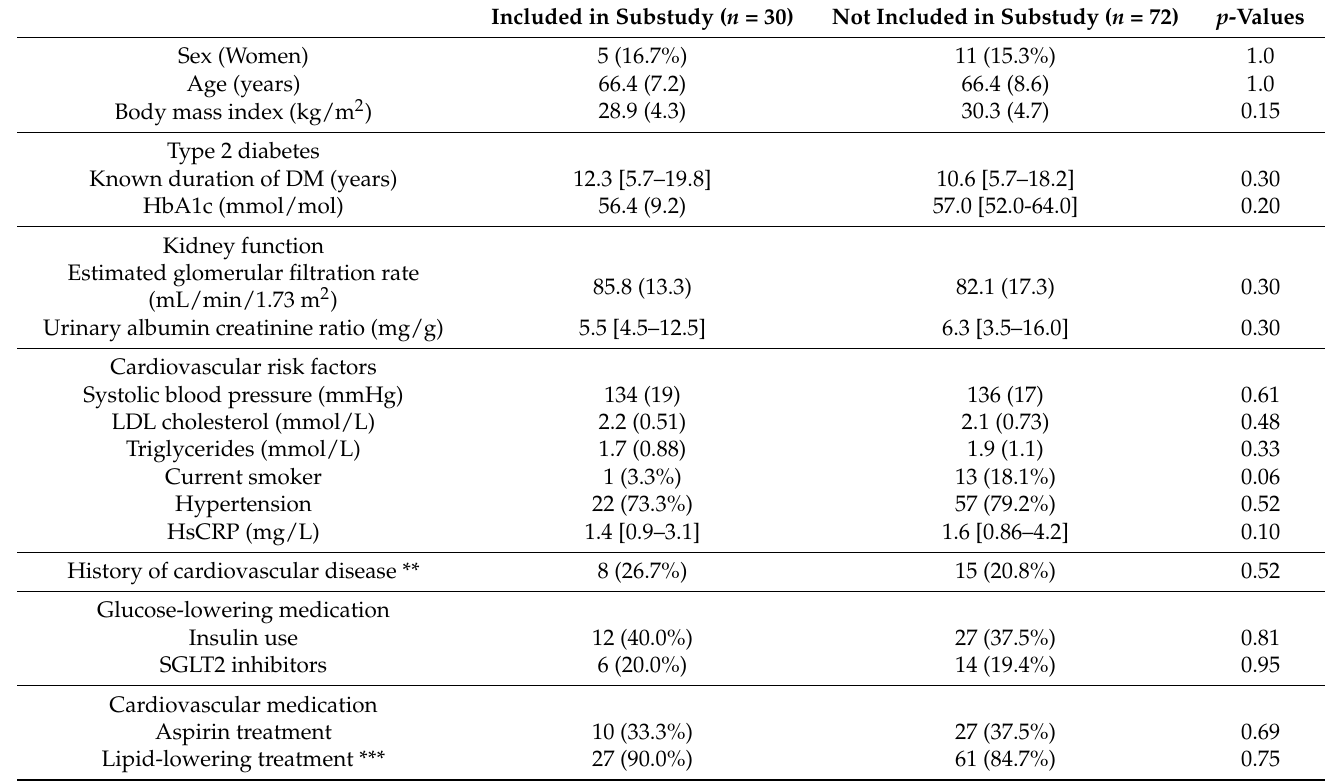
Table 2. Participants in the substudy compared to participants only included in the main study. Included in Substudy ( n = 30) Not Included in Substudy ( n =